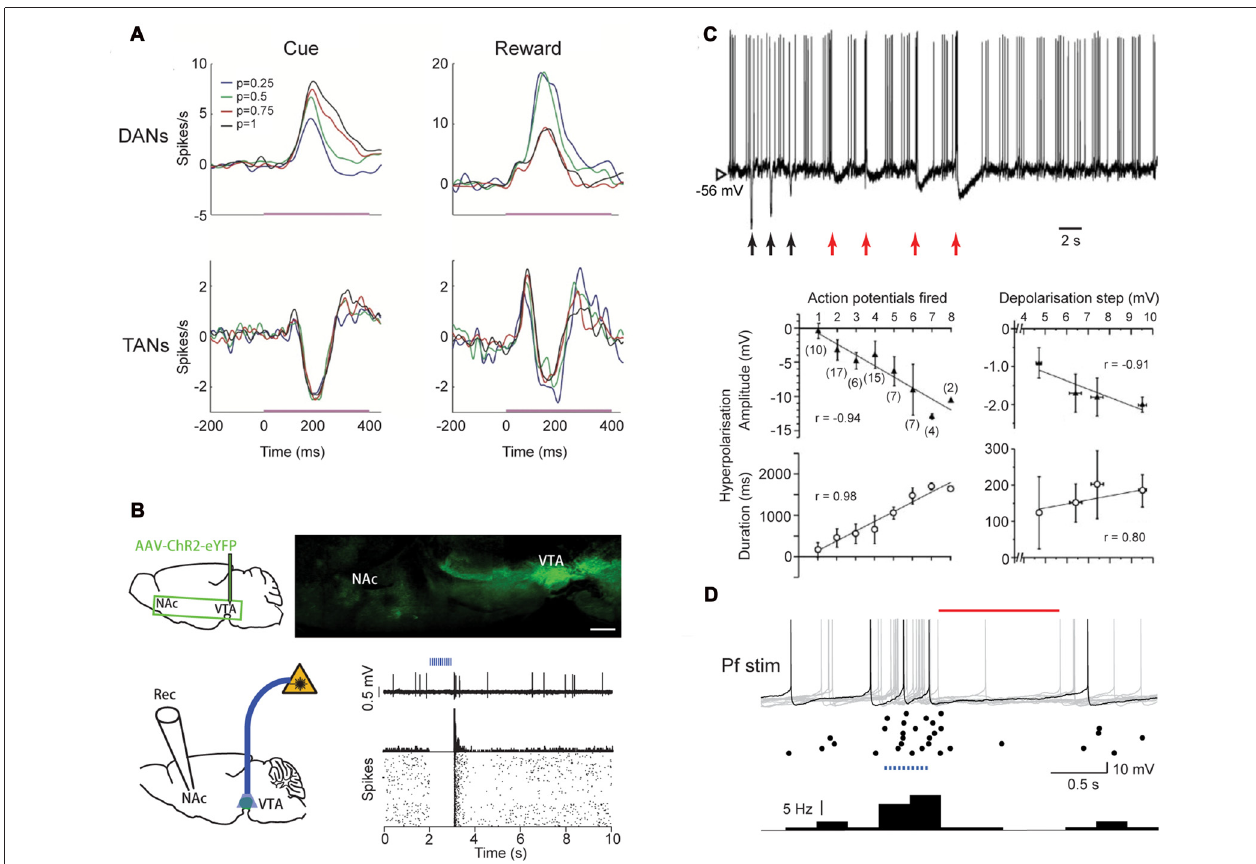
FIGURE 2 | Regulation of pause responses by inputs. (A) Dopamine neurons (DANs) and TANs respond to the cue and reward at similar latencies and duration but in opposite directions. Reward probability ( color coded ) modifies firing rate in DANs but not in TANs. Adapted from Morris et al. (2004). (B) Schematic diagram ( upper left ) and sagittal brain section ( upper right ) showing GABA neurons in VTA (GAD-Cre1 mouse) that project eYFP1-expressing axons to NAc. Activation of GABA neurons in VTA via an optic fiber (4-ms pulses, 20 Hz for 1 s) inhibits a ChI in NAc (PSTH, 5 ms bins and raster plots bottom right ). Adapted with permission from Brown et al. (2012). (C) Upper , Depolarization ( red arrows , 0.2, 0.4, 0.6, 0.8 nA), but not hyperpolarization ( black arrows , − 0.6, − 0.4, − 0.2 nA), of a ChI in the striatum in vivo induces a prolonged AHP. Lower , the amplitude and duration of the AHP is proportional to number of evoked action potentials number and depolarization step size. Adapted from Reynolds et al. (2004). (D) A pause in firing in ChIs ( red line ) in slices is induced following optogenetic activation (blue dots) of Pf afferents (400 ms train, 25 Hz). Upper , example current clamp traces superimposed ( gray ), with 1 typical trace highlighted ( black ), and middle , raster plot and lower , histogram (bin size 0.25 s, bottom). Adapted with permission from Kosillo et al.